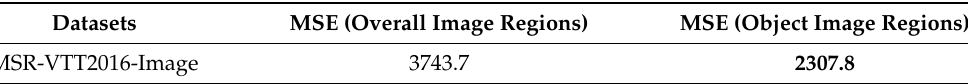
Table 1. Results of experiment 1 with MSR-VTT2016-Image dataset. The best value for each metric is shown using bold typeface.